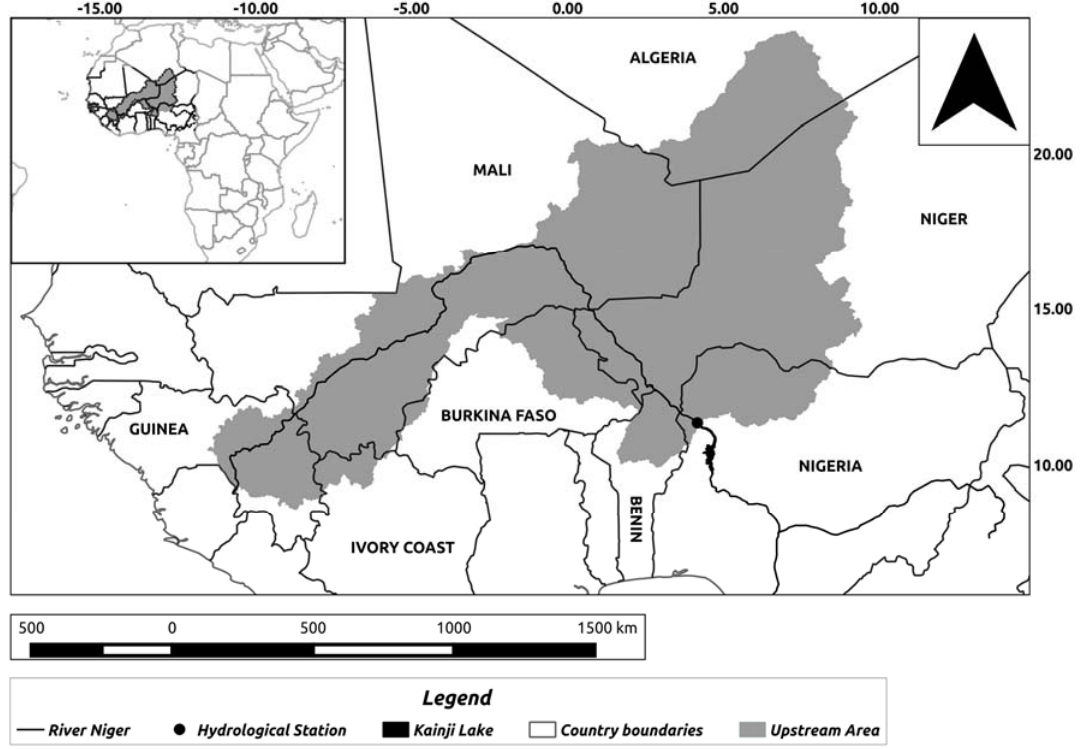
Figure 1. Upstream Niger basin area of Jidere Bode hydrological station.